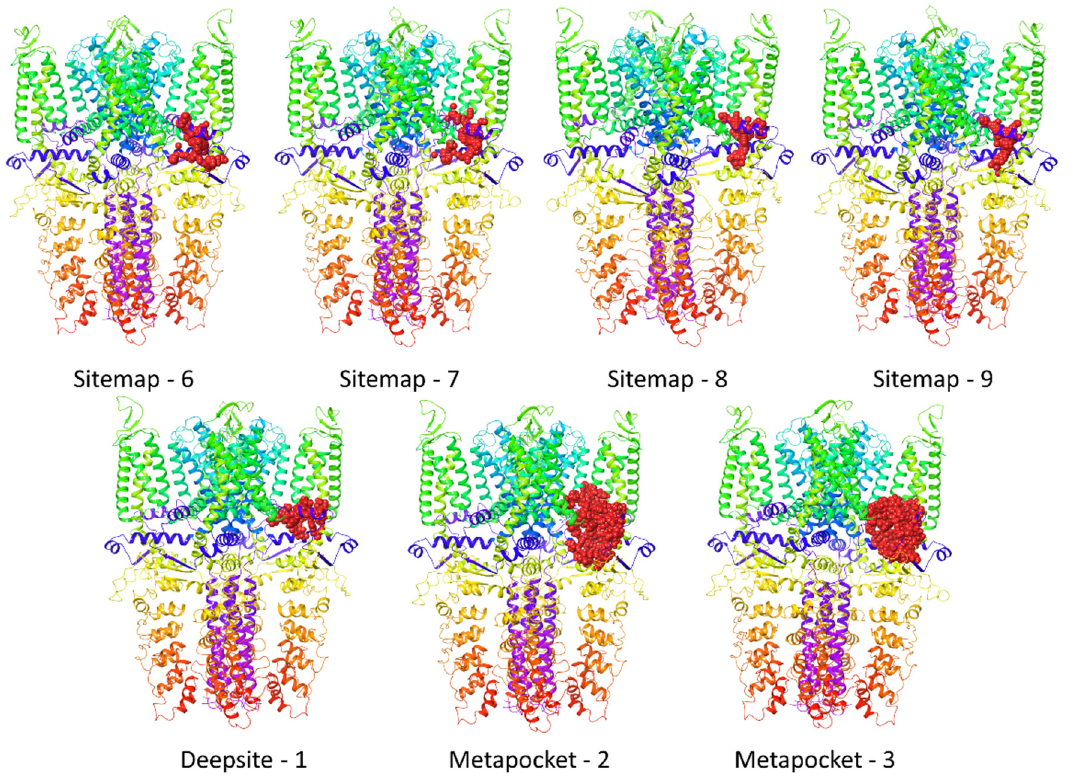
Figure 5. Selected binding sites for 6PQQ-based model from the group of pre-S1/S4/S5/TRP-like domain predictions.